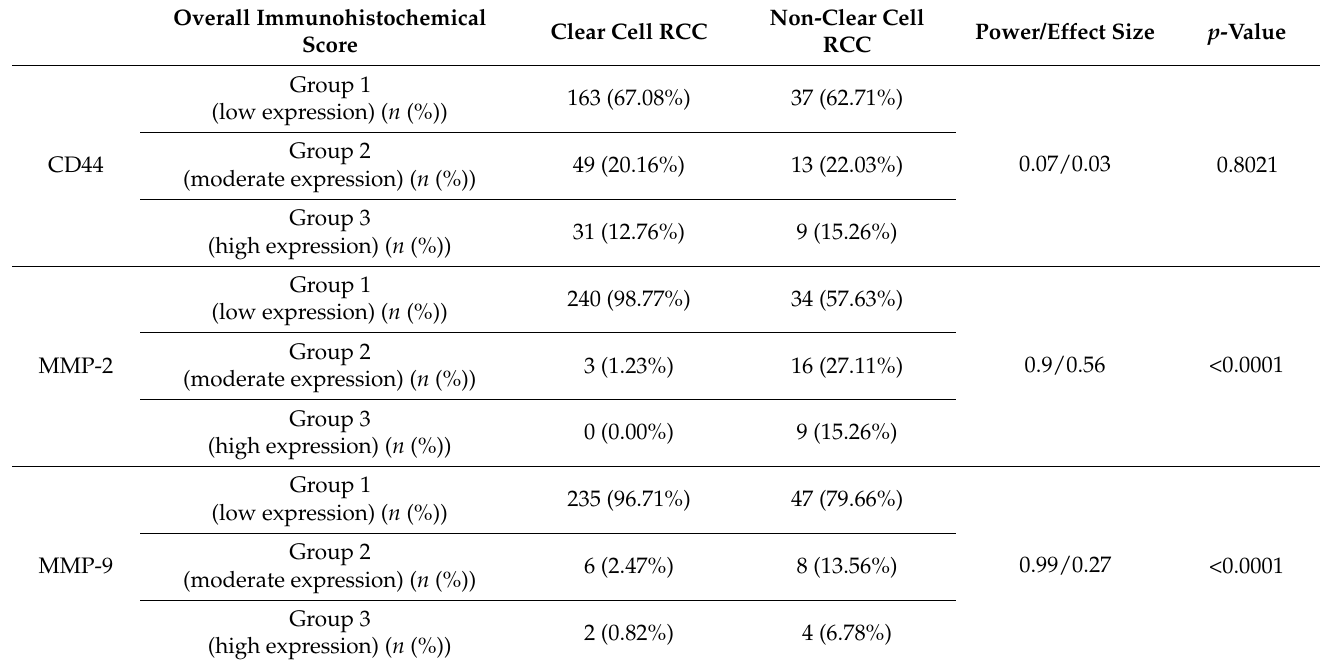
Table 3. Comparison of CD44, MMP-2 and MMP-9 immunoreactivity of clear-cell and non-clear-cell renal cell carcinoma cases.